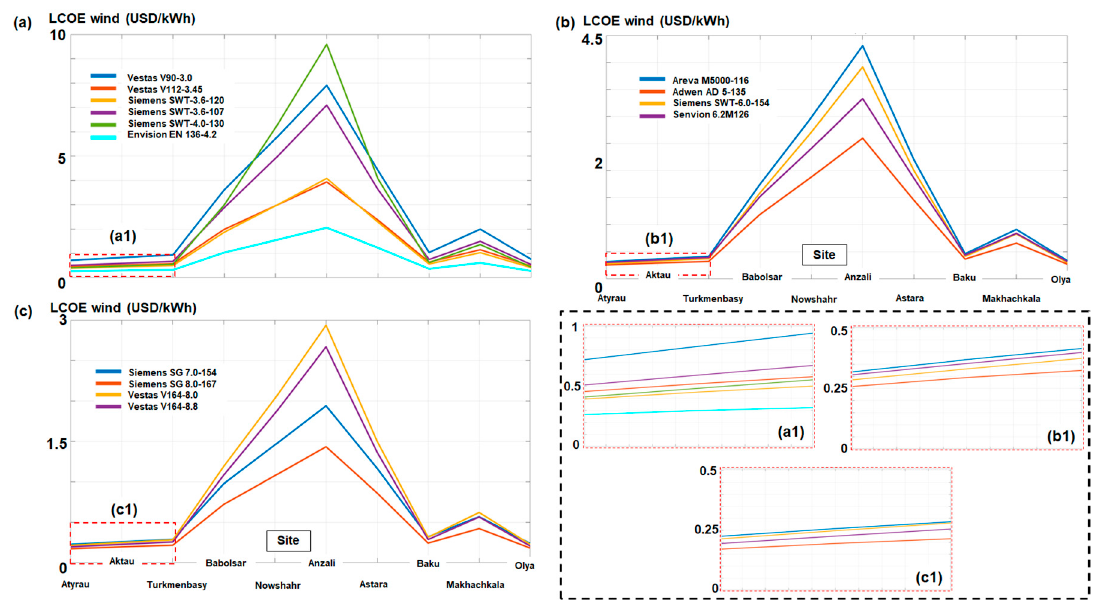
Figure 13. LCOE assessment considering the reference sites located at 5 km from the shore. The results were grouped in small, medium and large systems ( a, b and c ) including a detailed view of the values reported by the sites Atyrau, Aktau and Turkmenbasy ( a 1 , b 1 and c 1). All the turbines were evaluated for an 80 m hub height.